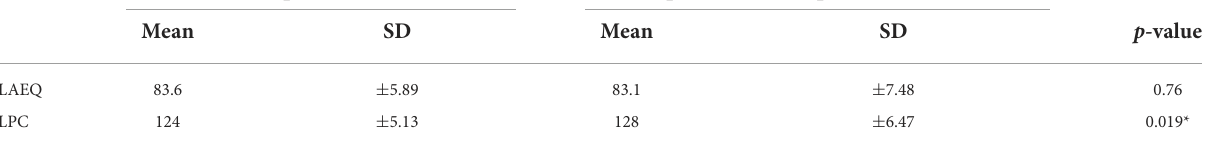
TABLE 4 Noise exposure assessment